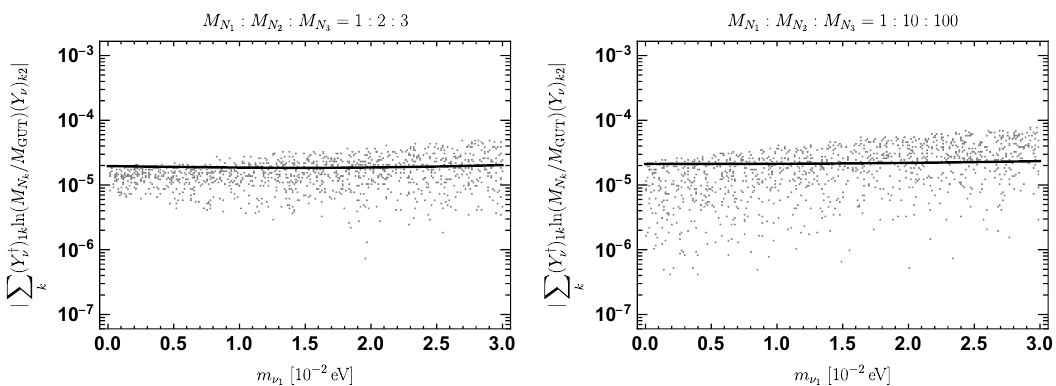
Figure 1 . The m ν 10 10 GeV and we consider two cases: i) M N 1 : 10 : 100 . The black line corresponds to the case with taking R = 1 .